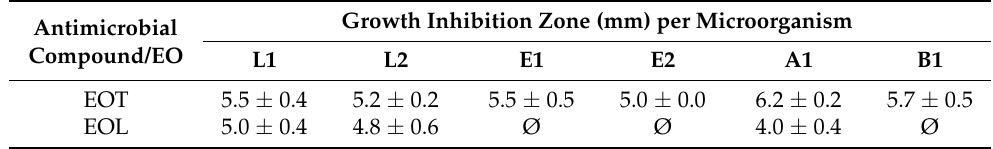
Table 4. Antimicrobial activity of the compounds by the agar diffusion method. Growth Inhibition Zone (mm) per Antimicrobial Compound/EO